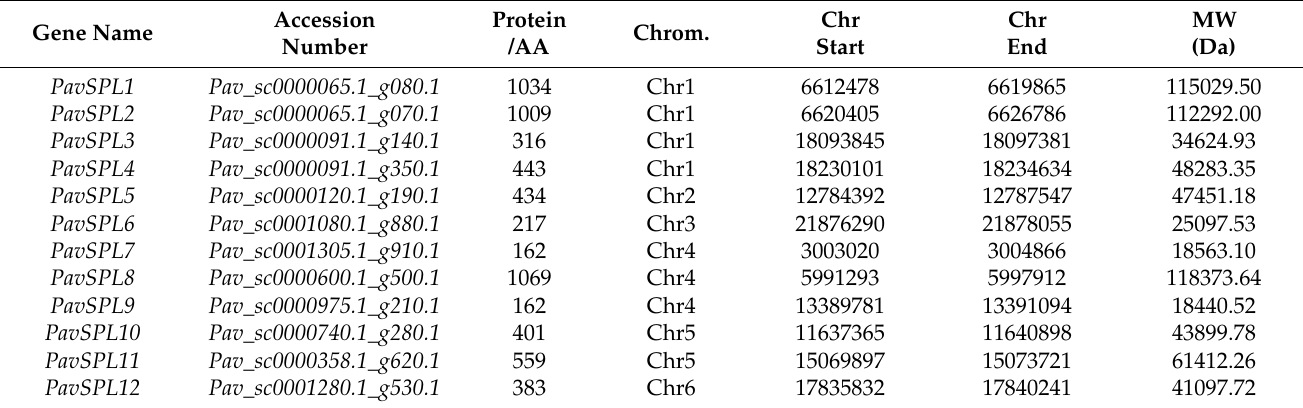
Table 1. The information on the SPL gene family in Prunus avium L.